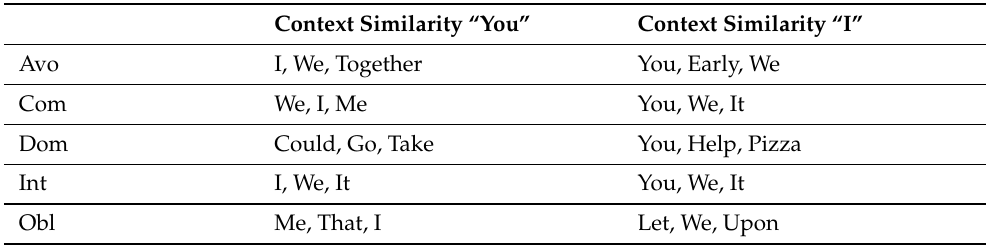
Table 8. Words that are used in similar contexts as the pronouns “You” and “I” across the documents measured with the Leacock–Chodorow algorithm.